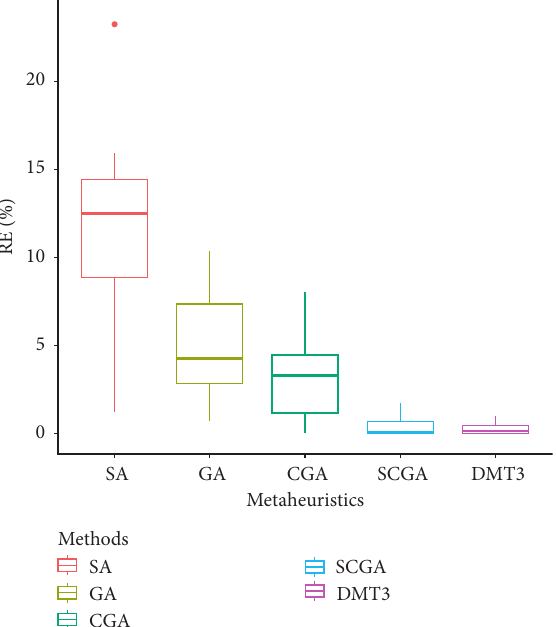
Figure 13: Box plots for comparing DM3 with SA, GA, CGA, and SCGA. Table 2: Solutions found by the proposed metaheuristic DM3. (a) chn31 (b) pr107 Geographical location of 31